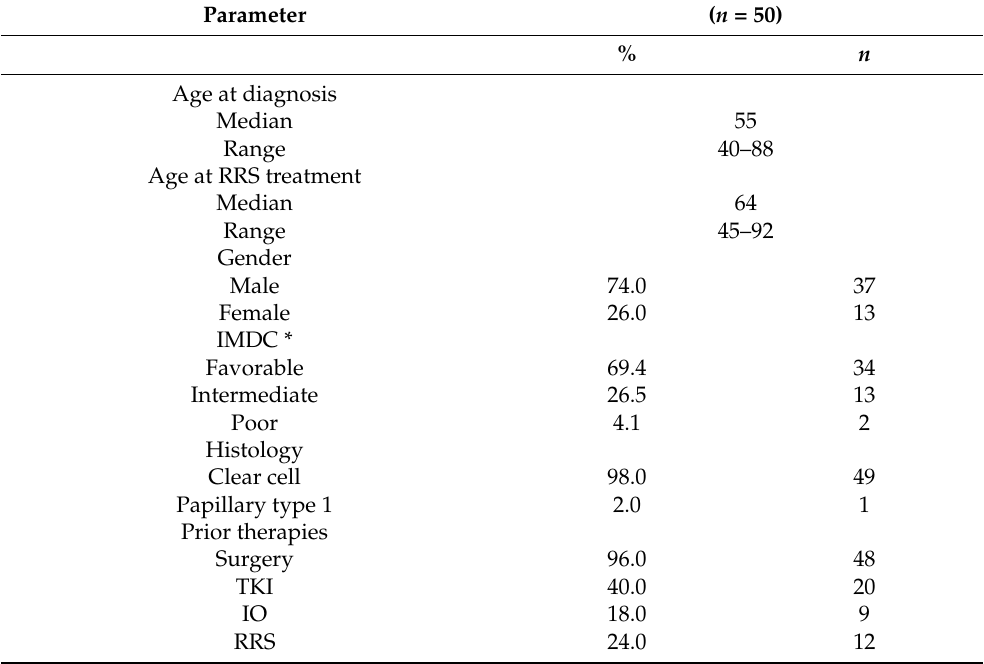
Table 1. Patient